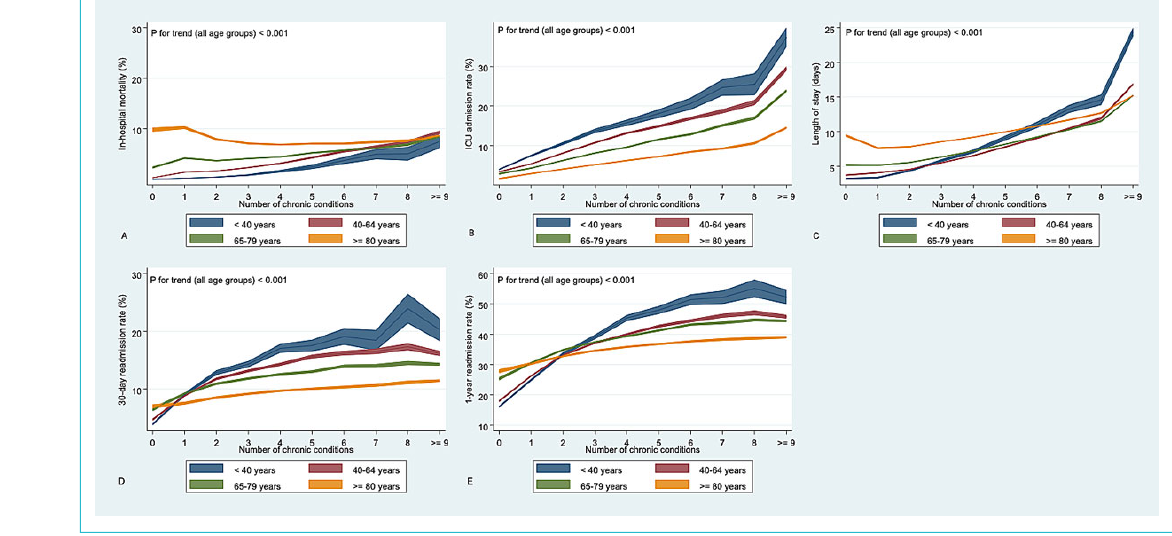
Figure 4: Odds-adjusted predictive margins for primary (A) and secondary outcomes (B-E) stratified by age